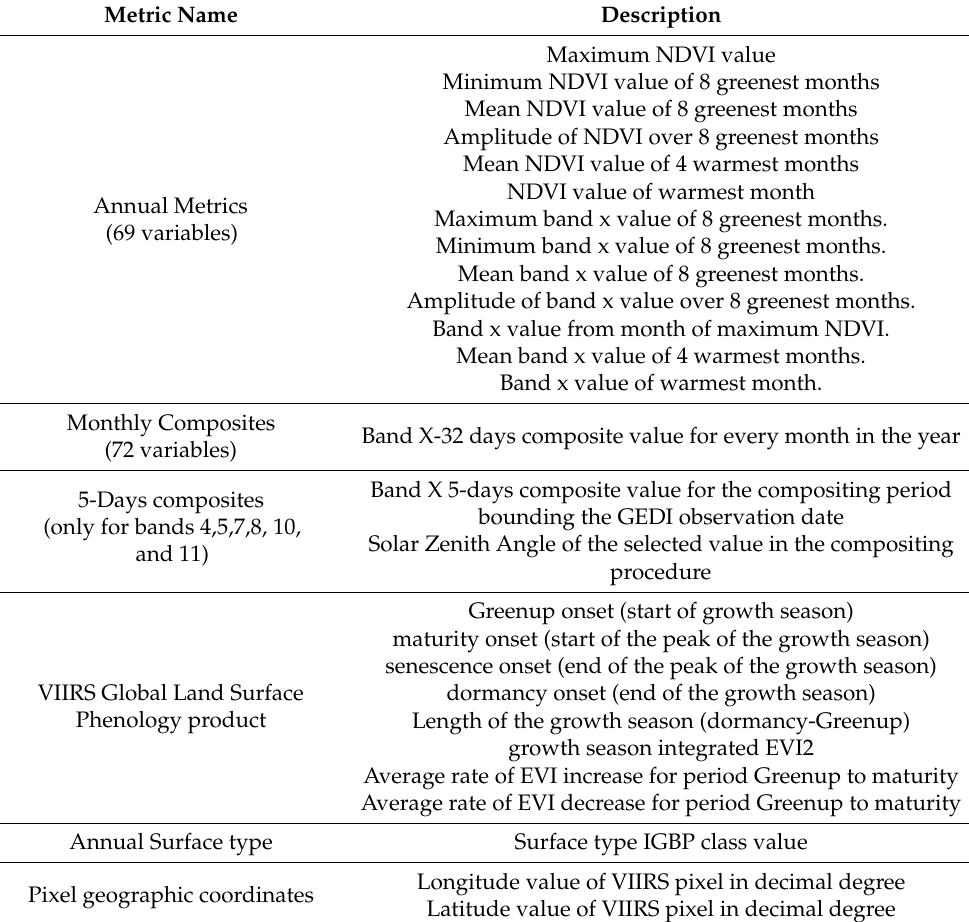
Table 2. Multi-temporal phenology metrics used to produce wall-to-wall maps of tree canopy structure. Band x refers to one of the bands listed in Table